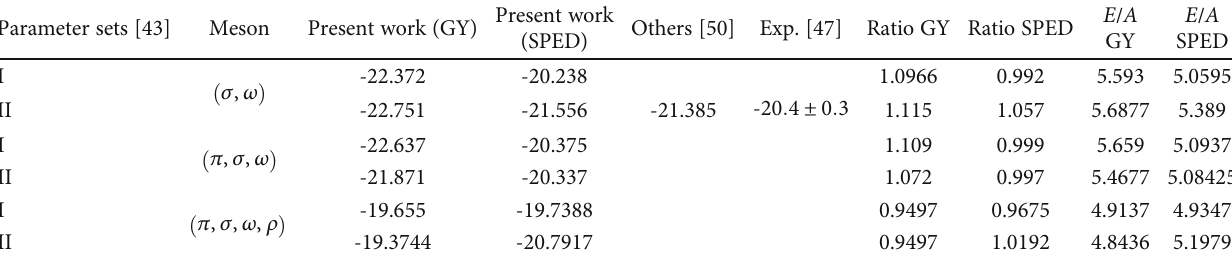
Table 6: The ground-state energy of 4 He nucleus through